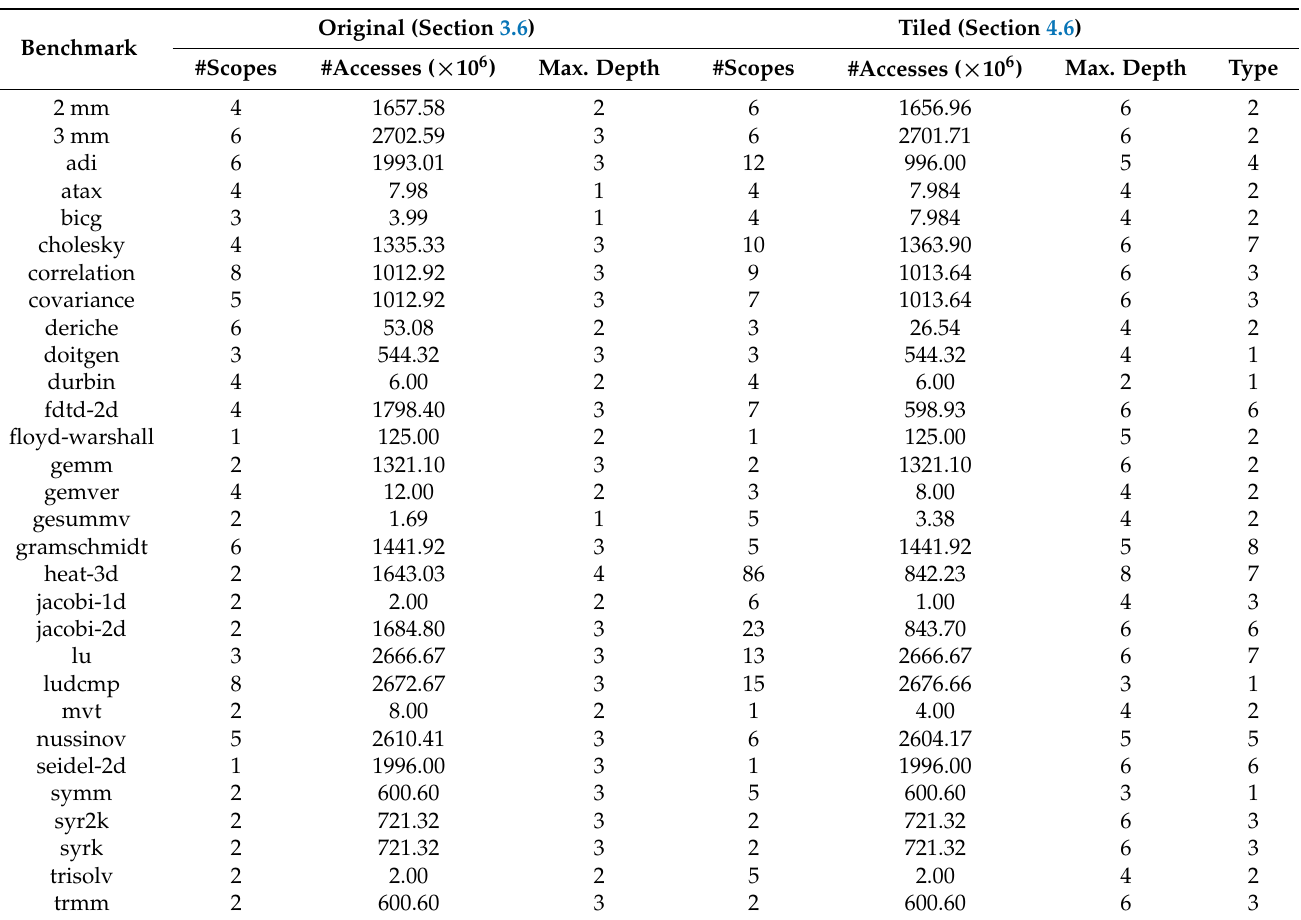
Table 1. Characteristics of the PolyBench/C benchmarks. The number of loop scopes, trace size and maximum loop depth are shown for both original and Pluto-tiled versions of each code. The “Type” column in the “Tiled” part shows the details of the benchmark grouping addressed in Section